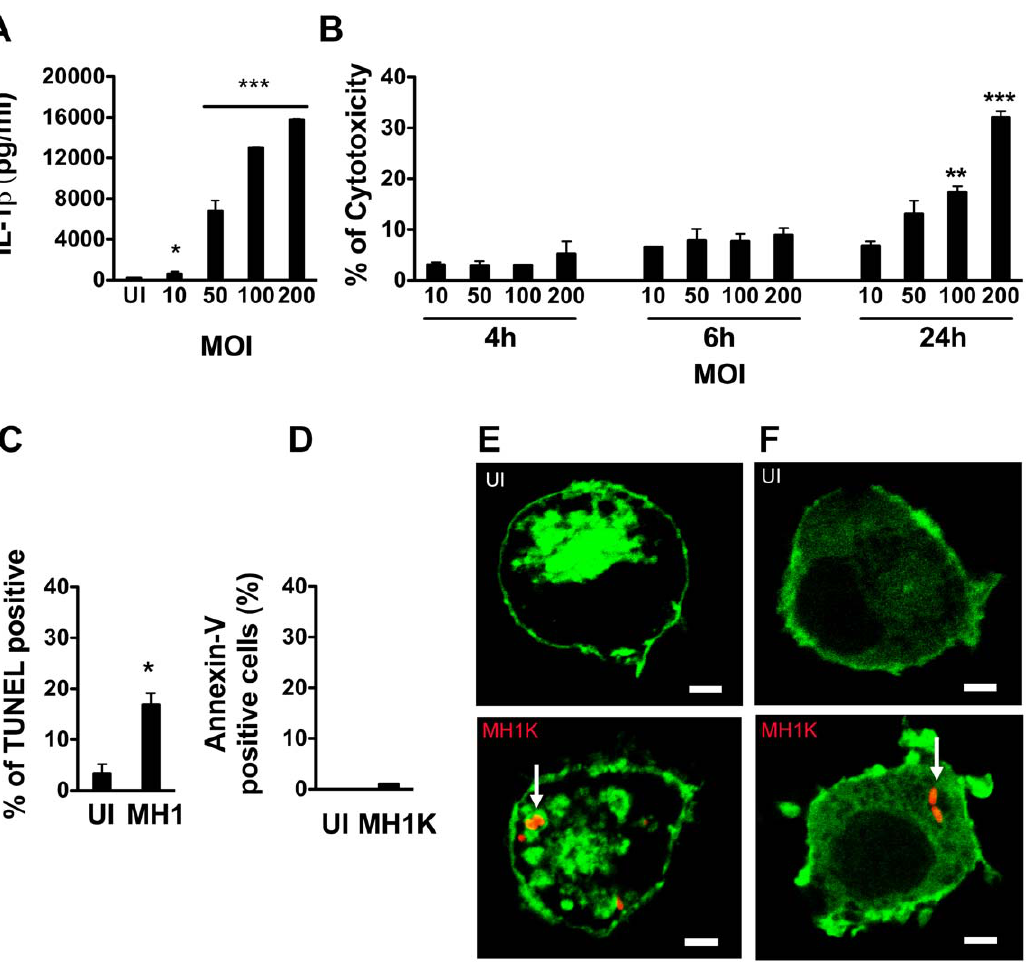
Figure 1. Burkholderiacenocepacia induces pyroptosis in macrophages. Graphs in (A) through (D) represent mean 6 SEM from three independent experiments. A. Macrophages were infected with B. cenocepacia MH1K at different MOIs for 1 h and then treated with gentamicin as described in Experimental Procedures. ELISA was used to quantify IL-1 b in cell supernatants at 24 h post-infection. * p # 0.05 and *** p # 0.001 values compared to uninfected (UI) macrophages. B. Macrophages were infected as in (A) and the supernatants were used to quantify total lactate dehydrogenase (LDH) activity at 4, 6 and 24 h post-infection. ** p # 0.01 and *** p # 0.001 values for MOI of 10 at 24 h post-infection. C and D. Macrophages were infected as in (A) and at 24 h post-infection stained with the TUNEL-AF488 kit (C) or with Annexin V-AF488 (D) * p # 0.05 values compared to UI macrophages. Stained cells were analyzed by flow cytometry. E and F. Confocal images at 24 h post-transfection of macrophages expressing the fluorescent probe Lact-C2-GFP (Green) (E) or PH-PLC d -GFP (Green) (F) Upper panels show UI macrophages. Lower panels show macrophages infected with B. cenocepacia MH1K-RFP (Red) for 4 h. Scale bar, 10 m m. Arrows indicate BcCVs.